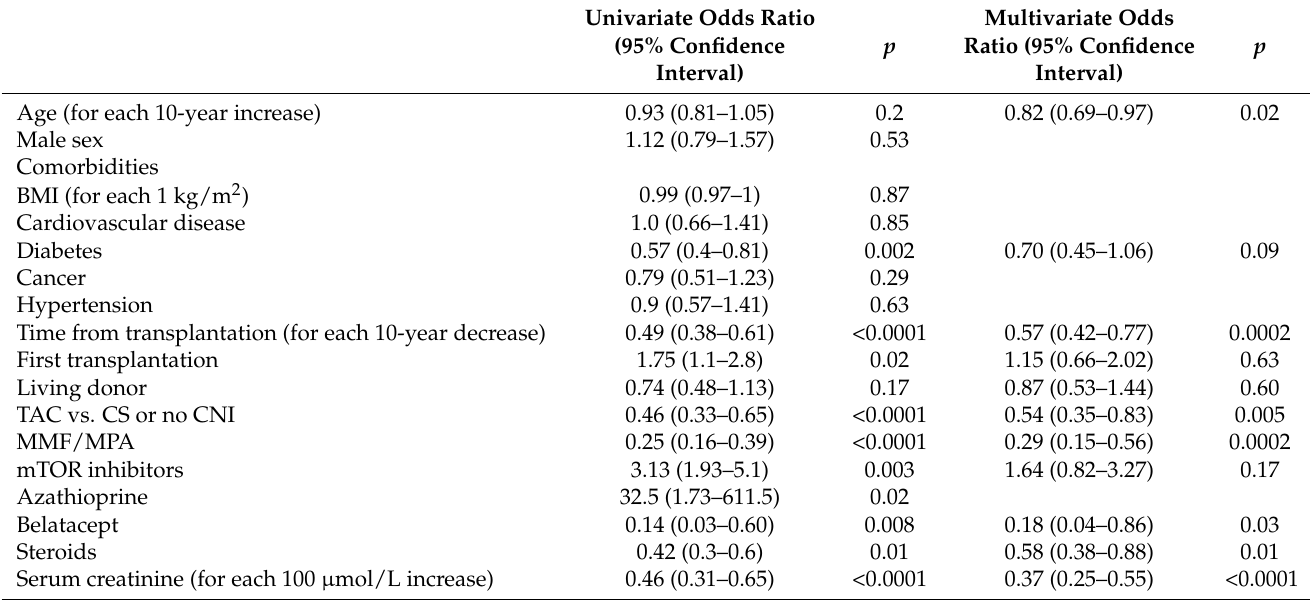
Figure 2. Distribution of the 562 KTRs according to the serological response assessed one month after the first, second, and third vaccine doses. Patients who harbored titers < 1 BAU/mL were considered as non-responders; conversely, those with titers between 1 and 7.1 BAU/mL were classified as weak responders. Patients with titers between 7.1 and 143 BAU/mL were considered as moderate responders; conversely, those with titers ≥ 143 BAU/mL were classified as good responders. Table 2. Univariate and multivariate analysis of predictors factors for seroconversion after two vaccine